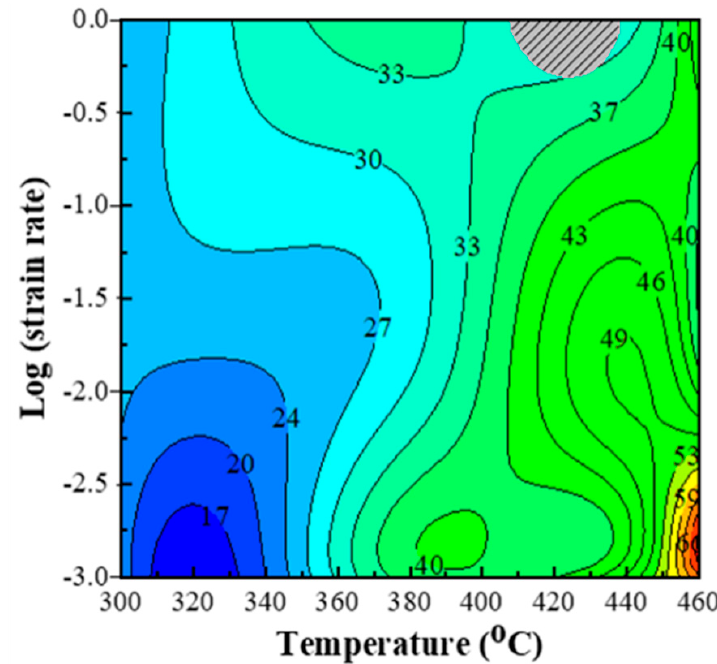
Figure 5. Processing map of the PM composites at true strain of 0.8 (the gray-shadowed areas represent the flow instability).